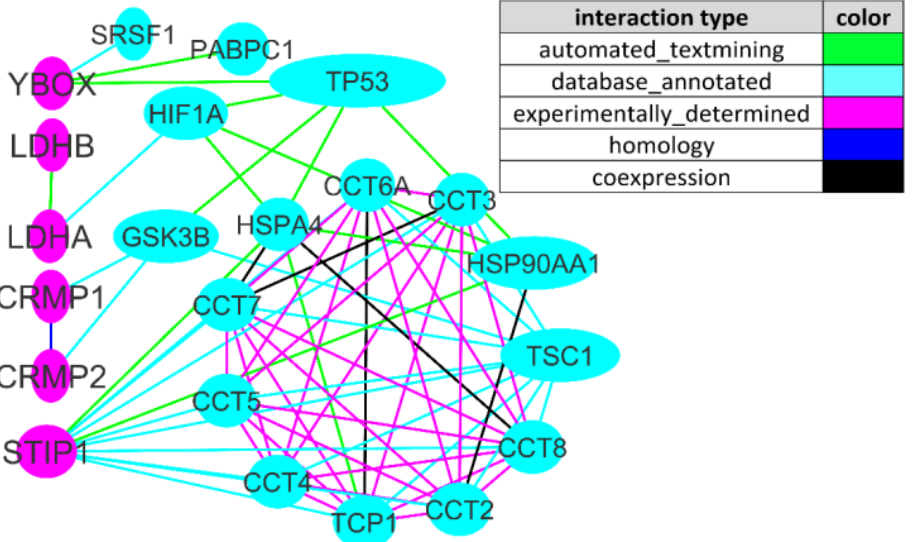
Figure 2. mTOR signaling pathway genes interacting with MAR ASD genes. The edges of the network are colored according to the type of interaction that had the highest confidence score. There were five dominant types of interactions: automated textmining (colored green), annotated database (colored cyan), experimentally determined (colored pink), homology (colored blue), and coexpression (colored black). mTOR signaling genes colored cyan, MAR ASD genes colored pink.